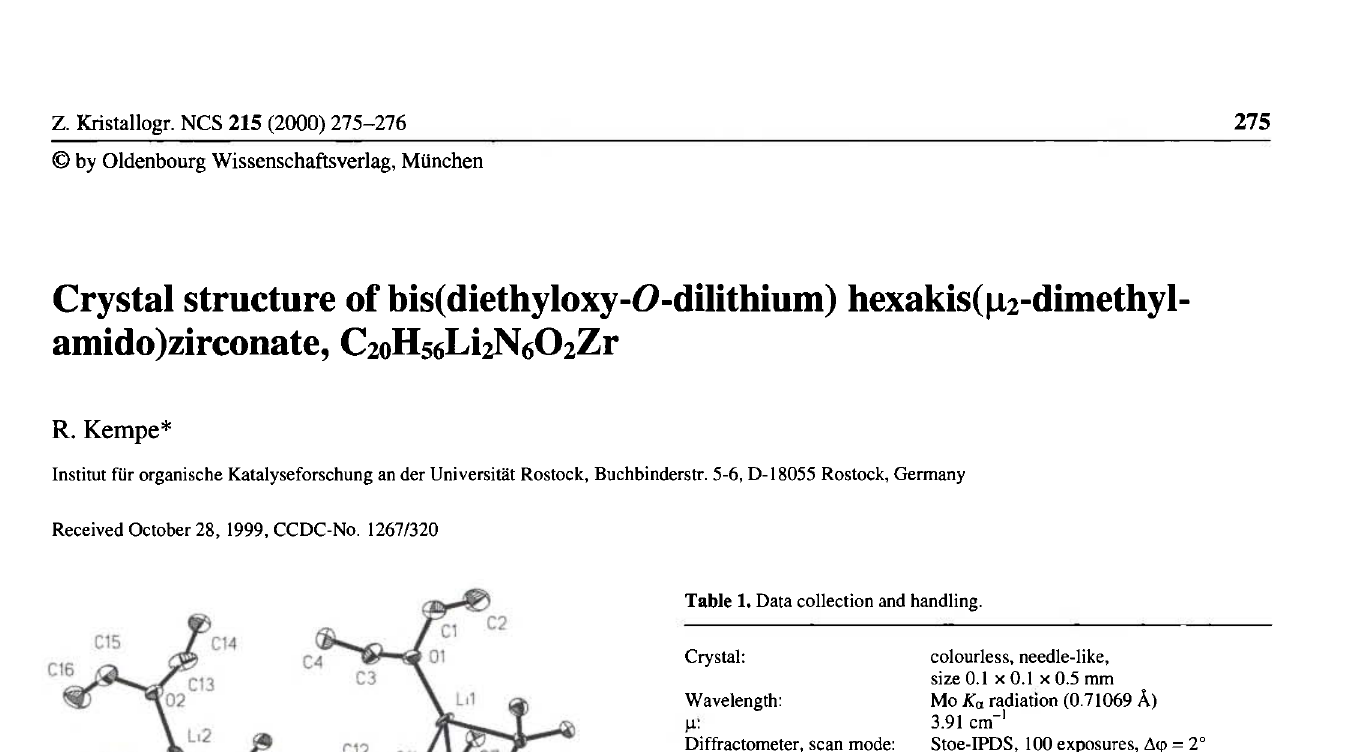
Table 2. Atomic coordinates and displacement parameters (in Ä 2